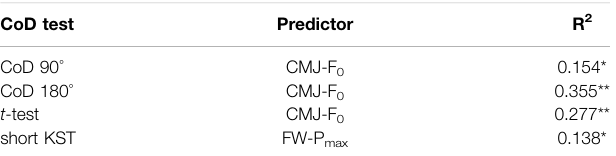
TABLE 4 | Predictors and percentage of explained variance for change of direction